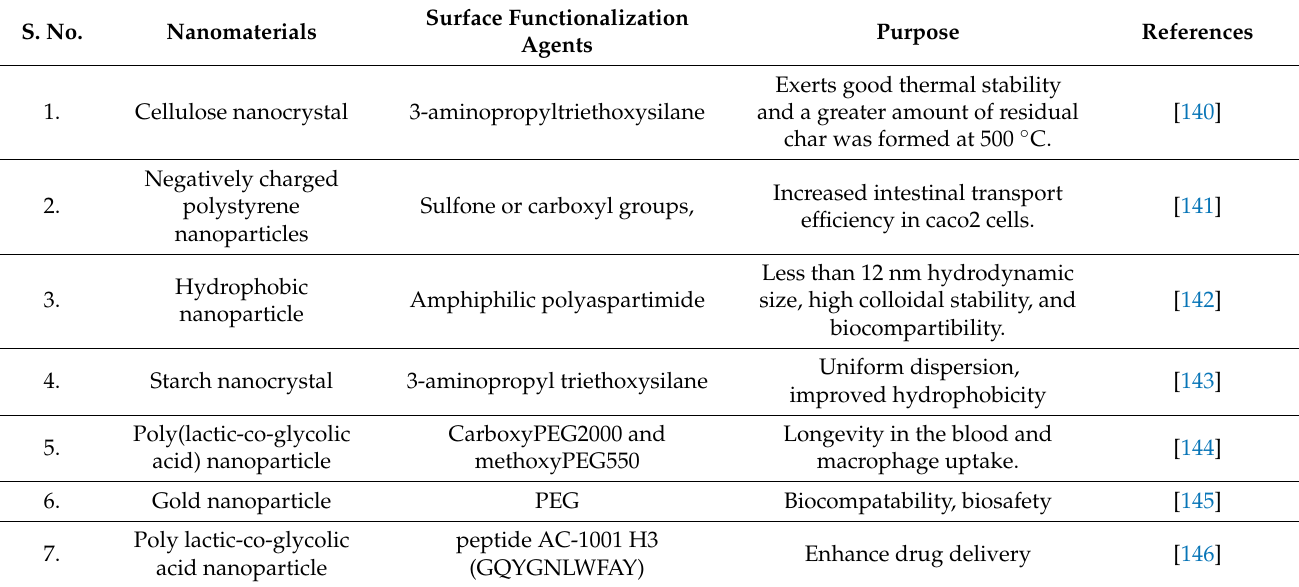
Table 3. Surface functionalization of